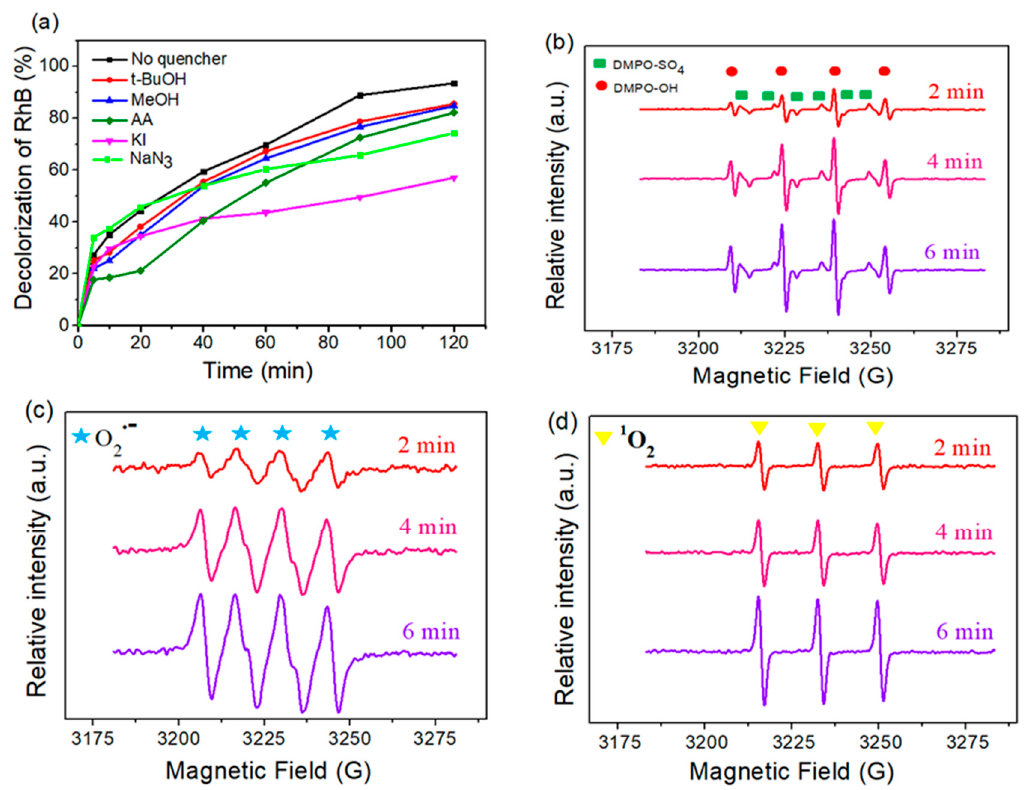
Figure 5. ( a ) Degradation of RhB in the presence of radical quenchers, ( b ) EPR spectra of DMPO-SO 4 or DMPO-OH, ( c ) EPR spectra of O 2•− radicals, and ( d ) EPR spectra of 1 O 2 in the Fe 3 O 4 @GO + K 2 S 2 O 8 system with